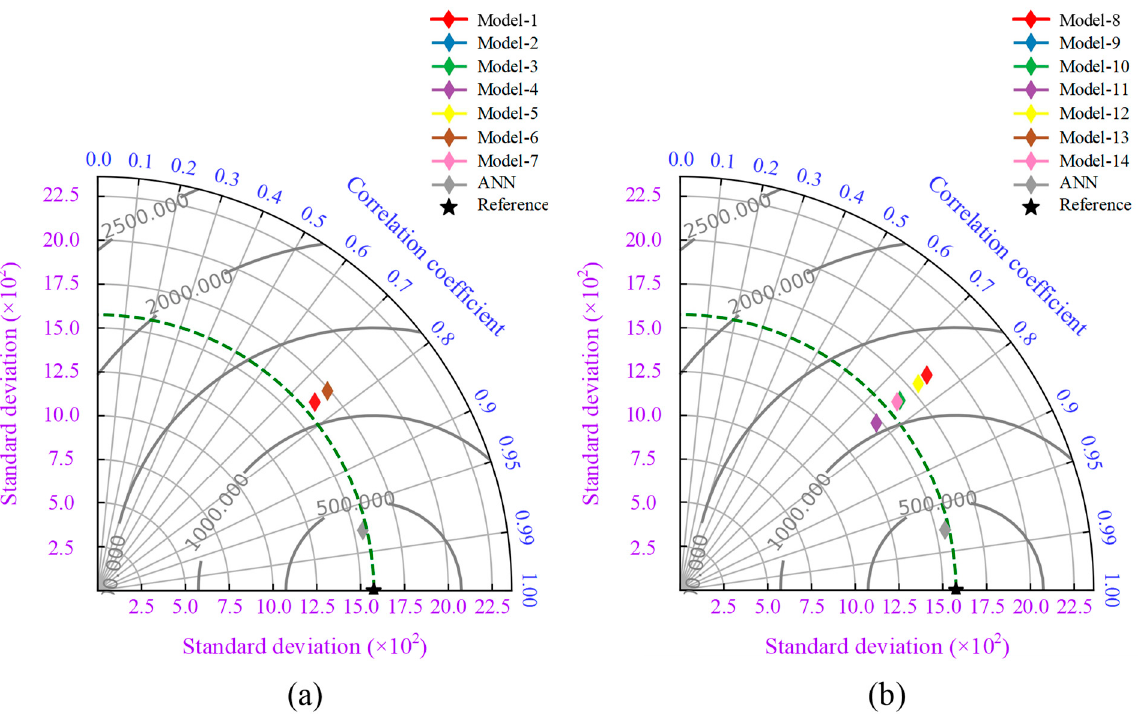
Figure 8. Taylor diagram ( a ) Group-I models with ANN and ( b ) Group-II models with